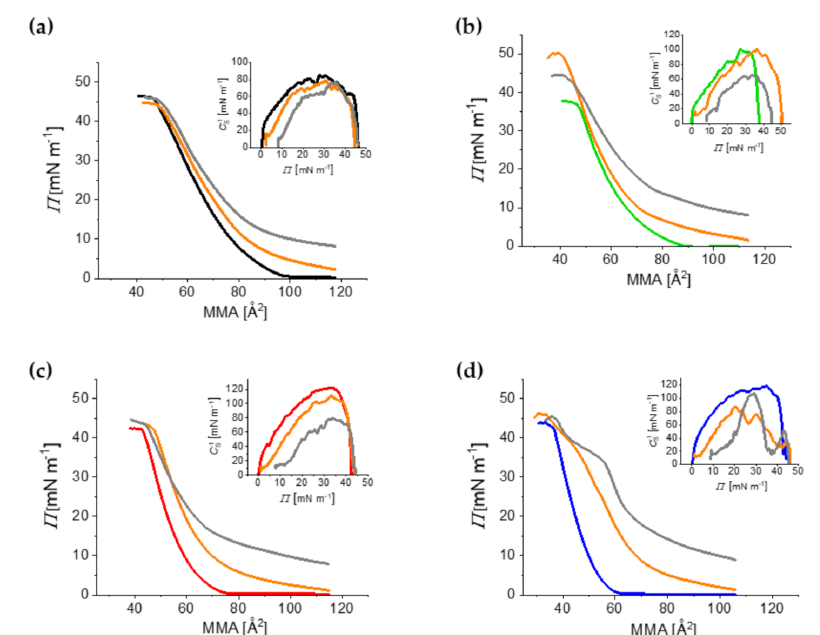
Figure 3. Π – A isotherms of SM/POPC ( a ), SM/POPC/CHOL 10 mol% ( b ), SM/POPC/CHOL 30 mol% ( c ), and SM/POPC/CHOL 50 mol% ( d ) spread on the water subphase (black ( a ), green ( b ), red ( c ) and blue ( d )) and the GOTCAB solution subphase with 8 (orange ( a – d )) and 80 (gray ( a – d )) mg · L − 1 GOTCAB. T = 20 ◦ C. Insets: C S − 1 – Π